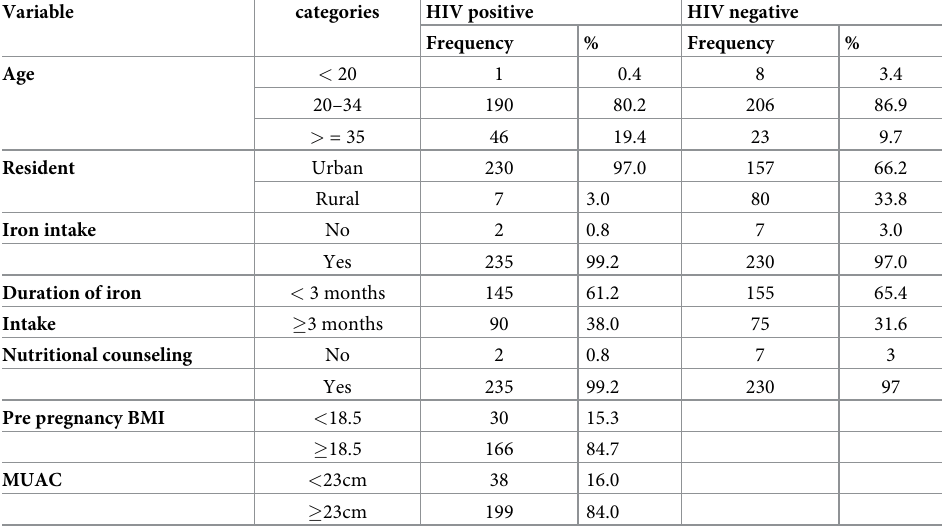
Table 1. Sociodemographic and nutrition-related characteristics of mothers delivered in Northwest Amhara regional state referral hospitals (N =